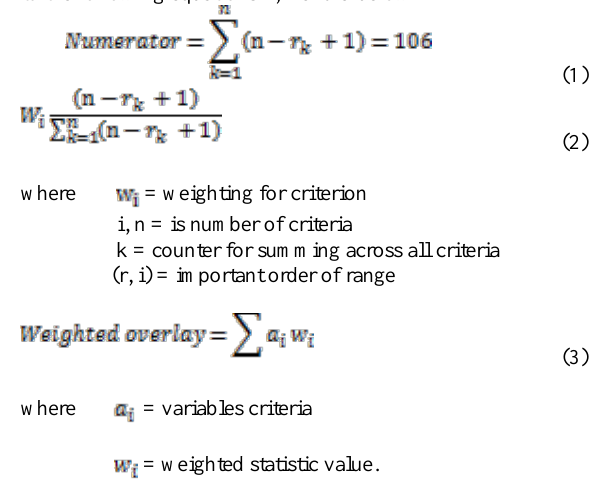
Table 1. Ranking and weighting of